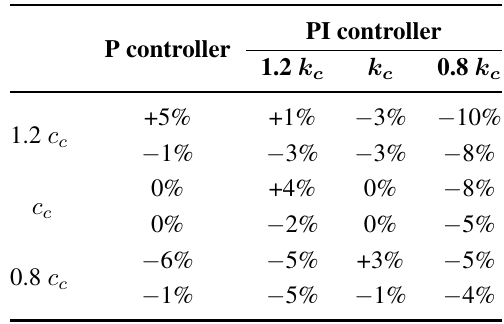
Table 4. Results of the sensitivity analysis for P and PI controller. Variation of the cross section area (red text) of Weld 1 and annual energy product (blue text), normalised by the controller where AEP is